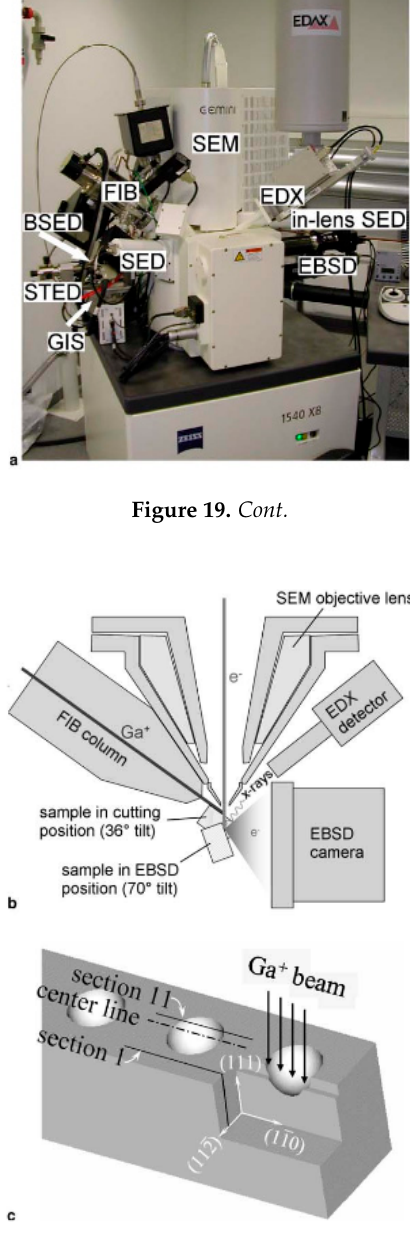
Figure 19. ( a ) Joint high-resolution field emission SEM/electron backscatter diffraction (EBSD) set-up together with a focussed ion beam (FIB) system in the form of a cross-beam 3D crystal orientation microscope for conducting 3D EBSD measurements by serial sectioning (Zeiss); ( b ) Schematic of the joint FIB/EBSD set-up; ( c ) Schematic of the FIB sectioning geometry [45]. Reproduced with permission from N. Zaafarani et al., Acta Materialia; published by Elsevier,